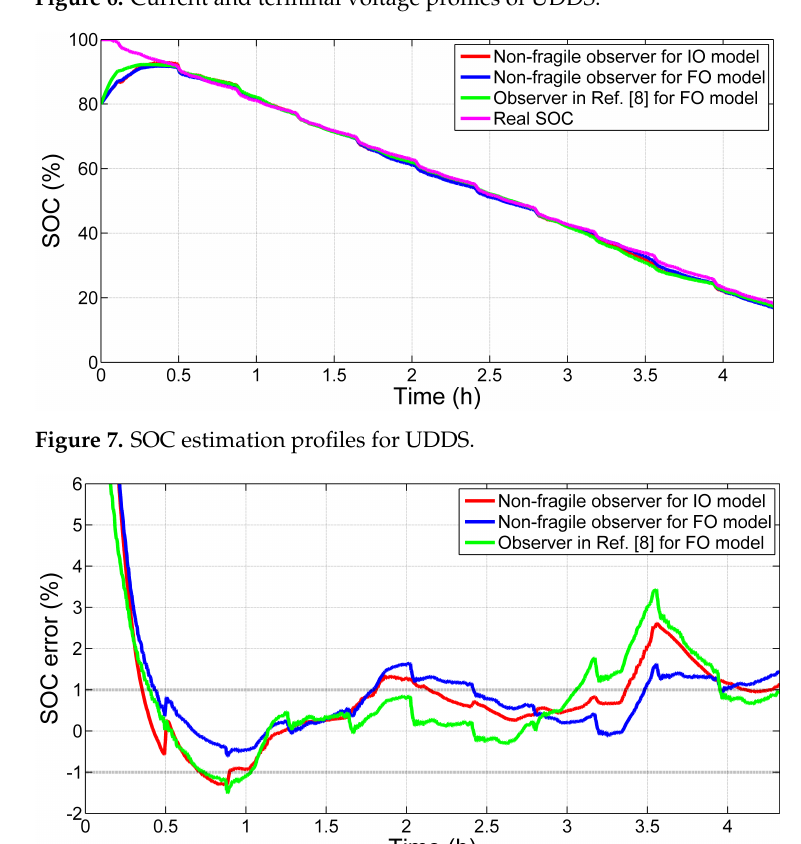
Figure 6. Current and terminal voltage profiles of UDDS.